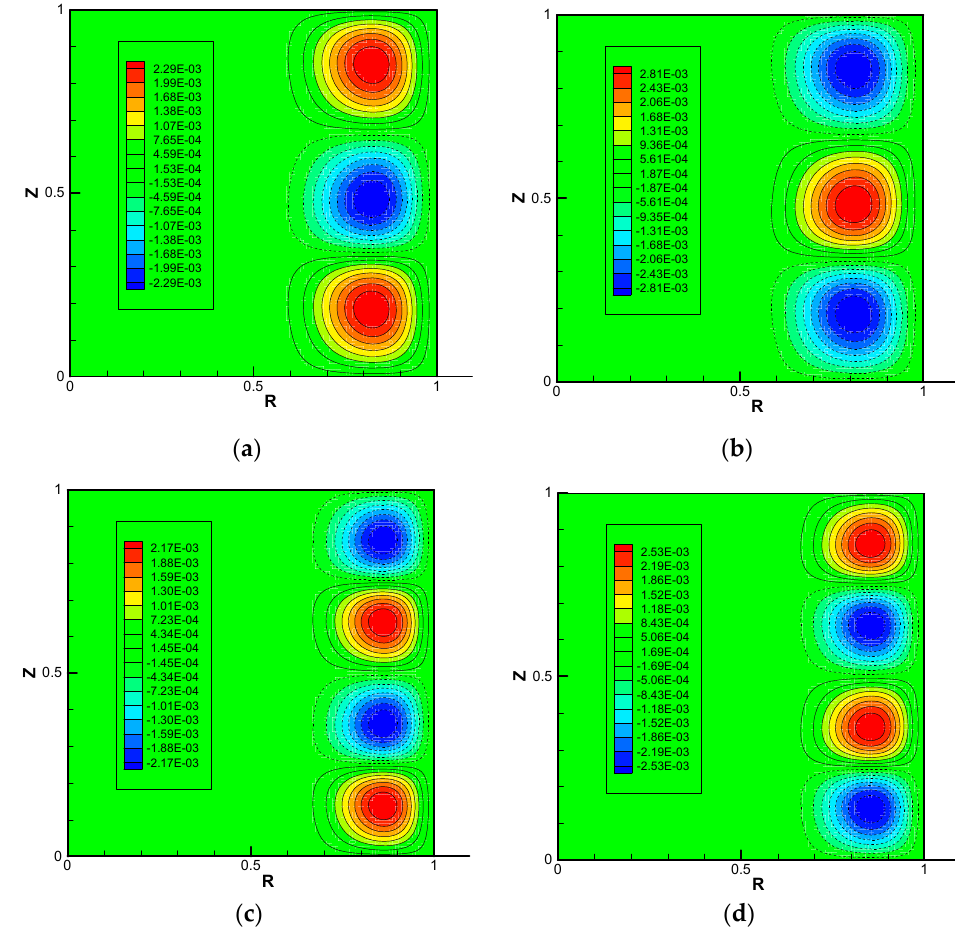
Figure 10. Contour line of the Stokes stream function and the electric potential at A = 1 and m = 1. ( a ) Stream function at Ha = 9 and Re = 450; ( b ) electric potential at Ha = 9 and Re = 450; ( c ) stream function at Ha = 16 and Re = 525; ( d ) electric potential at Ha = 16 and Re = 525.